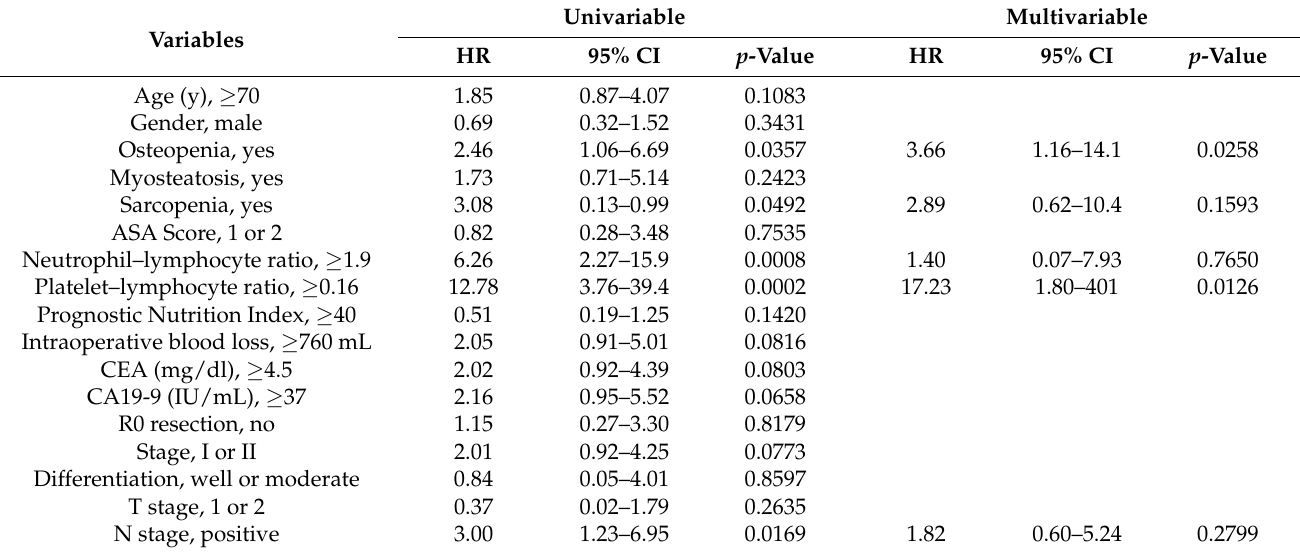
Table 2. Univariable and multivariable analysis for overall survival.